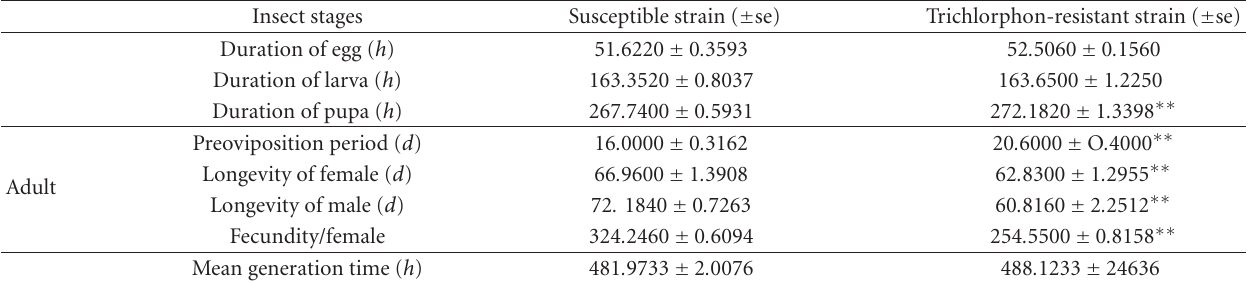
Table 2: The development di ff erence of each stage of two strains of B. dorsalis.